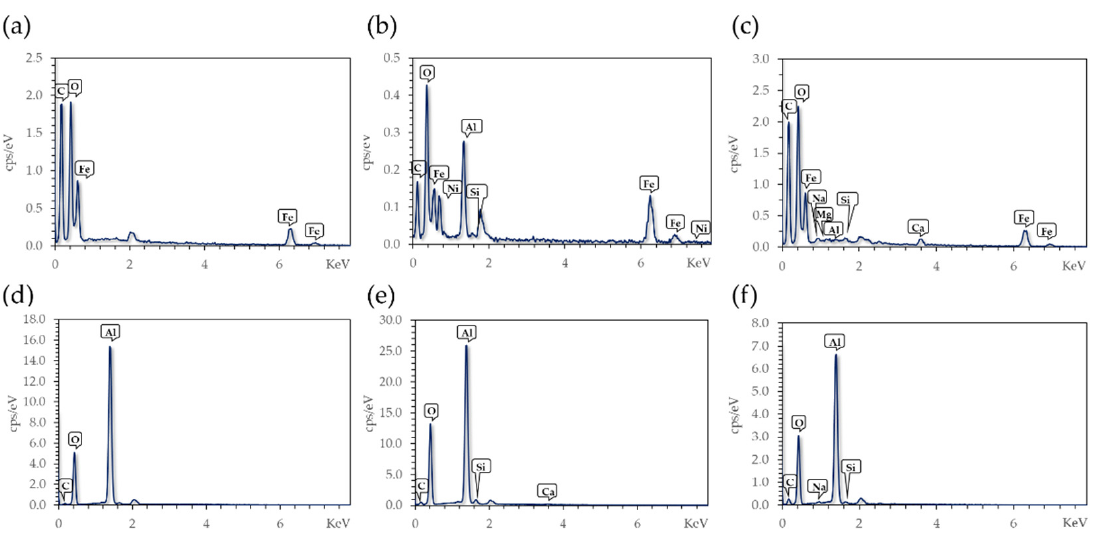
Figure 3. EDX results of ( a ) Fe 3 O 4 NPs, ( b ) Fe 3 O 4 NPs @APTES, ( c ) Fe 3 O 4 NPs @APTES after Cd removal, ( d ) Al 2 O 3 spheres, ( e ) Al 2 O 3 spheres @APTES, and ( f ) Al 2 O 3 spheres @APTES after Cd removal.